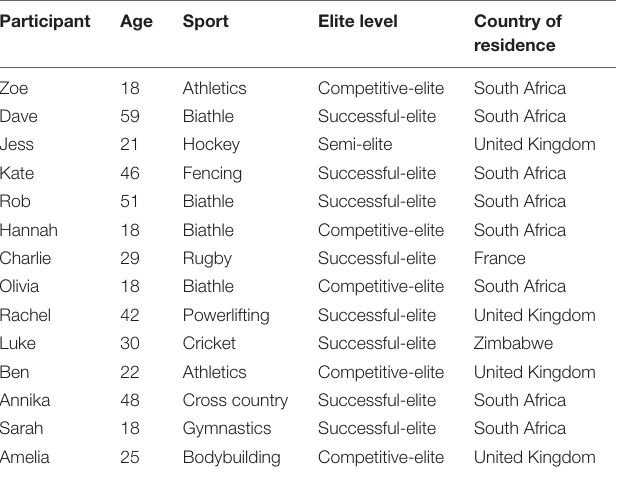
TABLE 1 | Participant demographic